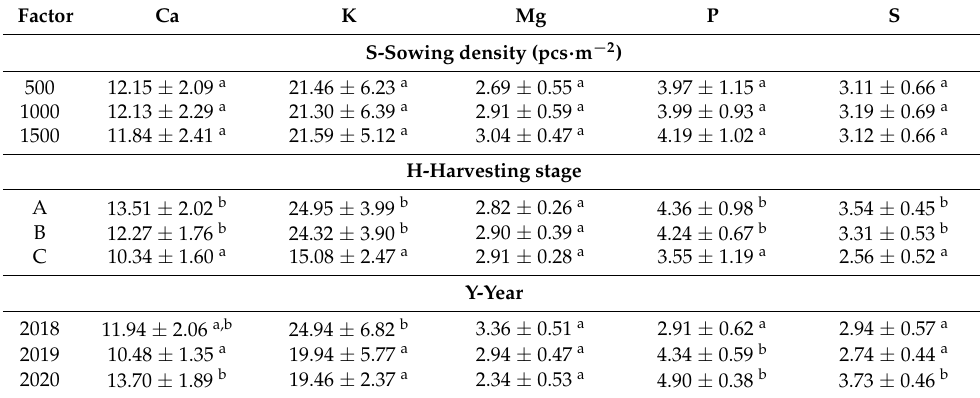
Table 5. Macronutrient content in Melilotus albus plants [mg · g − 1